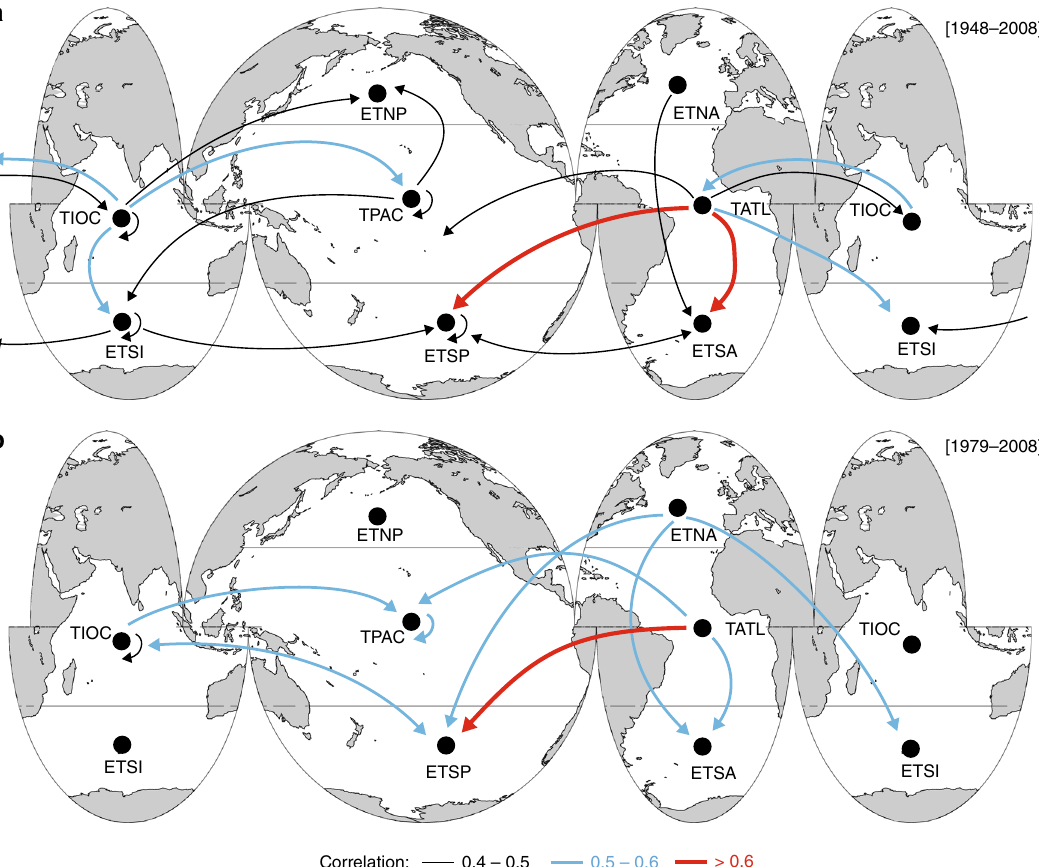
Fig. 8 Maps of the inter-regional correlations between Sea Surface Temperature and Wave Power. Spatial map of the correlations between the regionally- averaged seasonal time series of Sea Surface Temperature and Wave Power for the periods a 1948 – 2008 and b 1979 – 2008. The arrows size and color indicate the maximum correlation coef fi cient between the regional Sea Surface Temperature in the origin region (from) with the seasonal Wave Power in the target region (to). Only the correlations that are signi fi cant at the 95% level are shown. The correlation coef fi cients correspond to the maximum values in Table 1. The ocean sub-basins correspond to: extratropical North Paci fi c (ETNP), tropical Paci fi c (TPAC), extratropical South Paci fi c (ETSP), extratropical North Atlantic (ETNA), tropical Atlantic (TATL), extratropical South Atlantic (ETSA), tropical Indian Ocean (TIOC) and extratropical South Indian Ocean (ETSI). Equivalent results for the time series during the satellite era (1979 – 2008) and the non-autocorrelated residuals can be found in the Supplementary